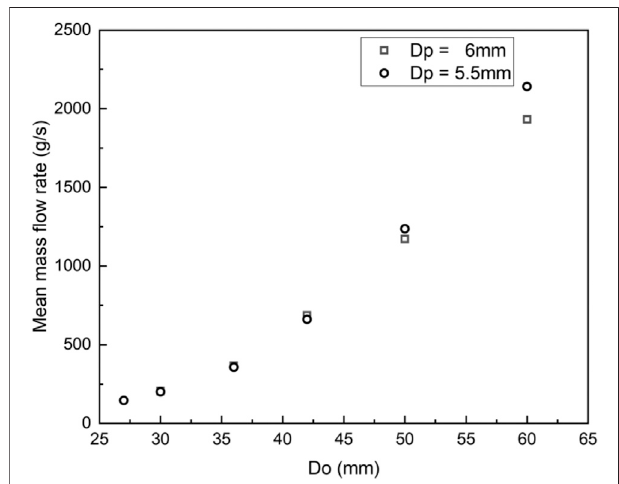
FIGURE 4 | Mean mass fl ow rate of two sets of particles at different ori fi ces